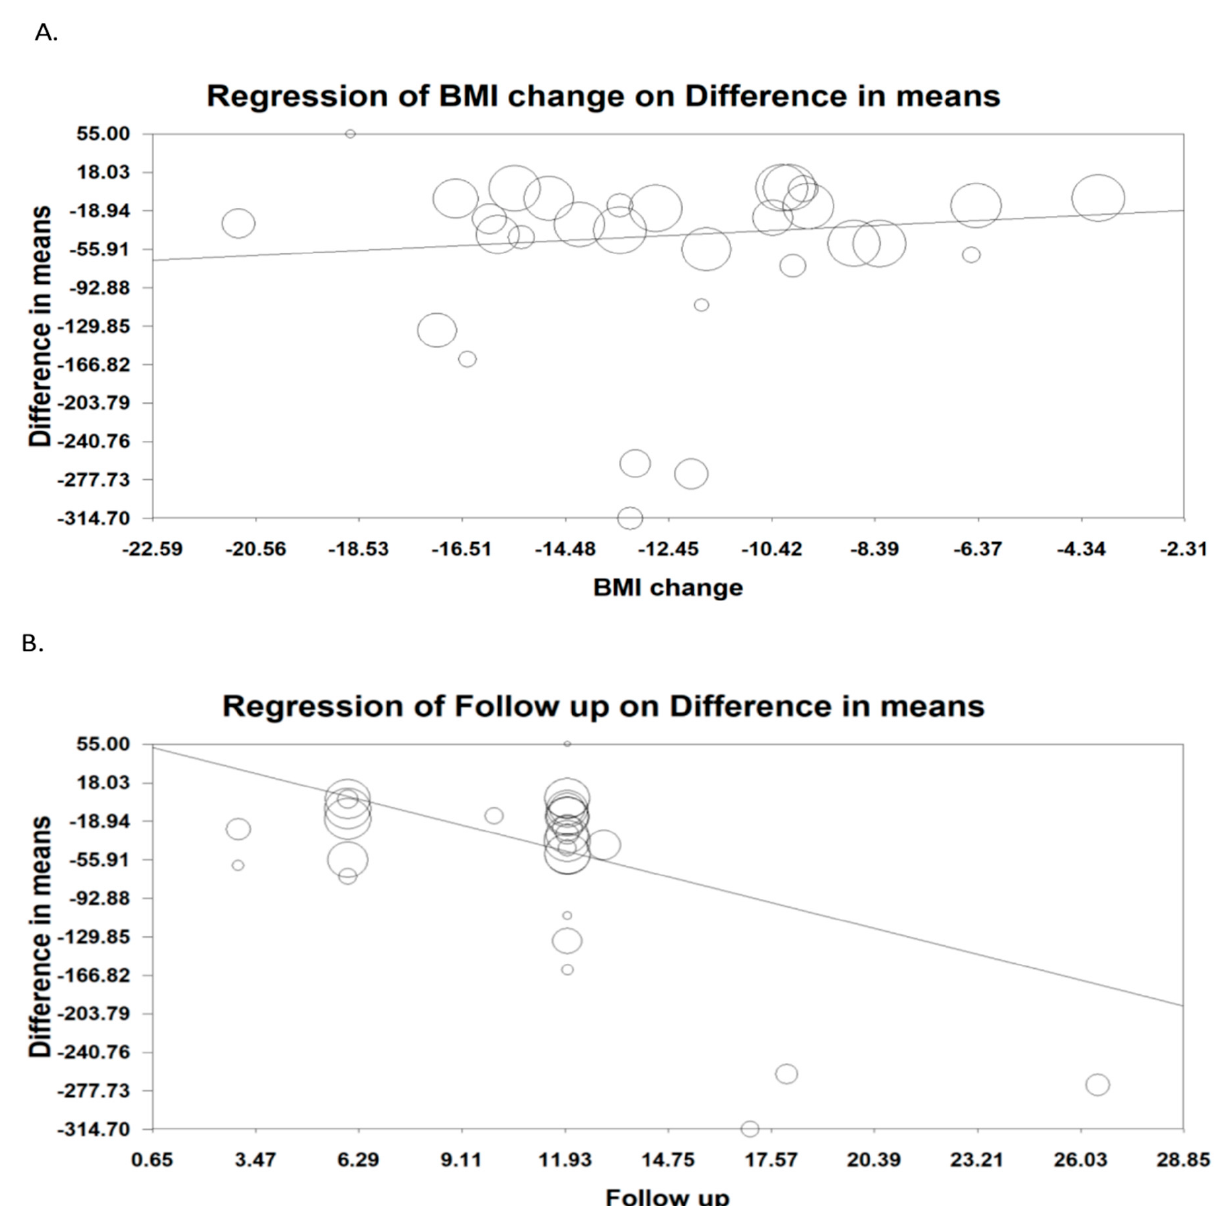
Figure 3. Random effect meta-regression for evaluating the effect of: ( A ) BMI change; ( B ) Follow-up duration.